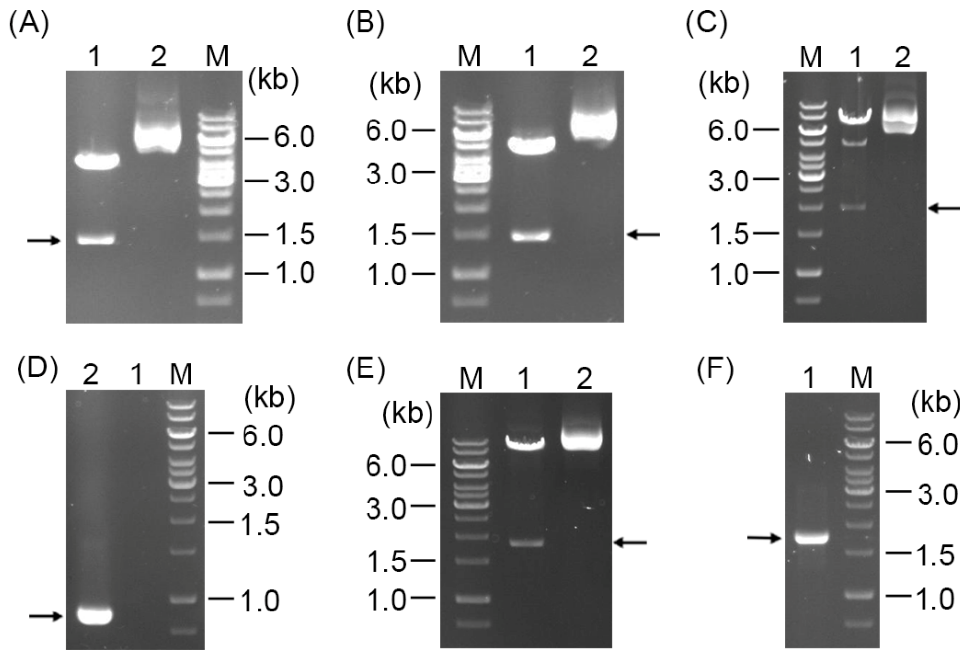
Figure 3. Confirmation of the structures of recombinant plasmids and the pDG148-containing strain of B. cereus . ( A ) Digestion of plasmid pSG1151-0.6 gerR - SGFP2 with Kpn I and Spe I. Lane 1—the black arrow denotes the expected ~1.5 kb size of the 678 bp gerRB fused to SGFP2 ; lane 2—intact plasmid. ( B ) Digestion of plasmid pSG1164-0.6 gerR - SGFP2 with Kpn I and Spe I. Lane 1—the black arrow denotes the expected ~1.5 kb size of the 678 bp gerRB fused to SGFP2 ; lane 2—intact plasmid. ( C ) Digestion of plasmid pSG1164-1.2 gerR - SGFP2 with Kpn I and Spe I. Lane 1—the black arrow denotes the expected size of the 1234 bp gerR fused to SGFP2 (~1.8kb); lane 2—intact plasmid. ( D ) Analysis of the integration of plasmid pSG1164-1.2 gerR - SGFP2 in B. cereus . Lane 1—the expected size of the 870 bp gerRB fragment. ( E ) Digestion of plasmid pDG148- gerRB - SGFP2 with Sal